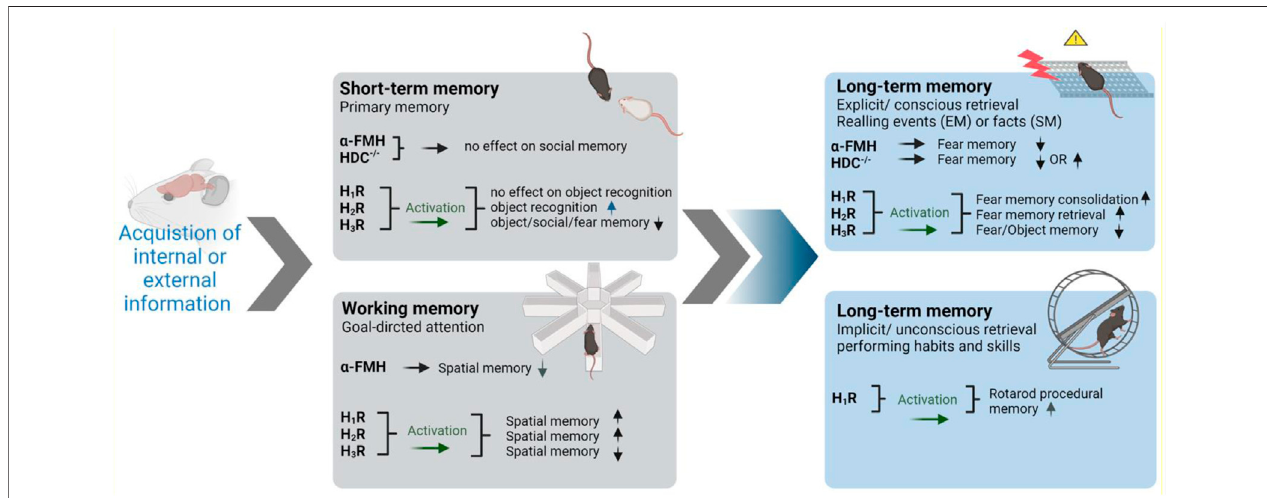
FIGURE 1 | Involvement of brain histamine in various types and stages of memory in preclinical studies. Symbolic photos were used to represent the most utilized behavioral task in each category. α -FMH, α - fl uoromethylhistamine; HDC-/-, histidine decarboxylase homozygous knockout mice; EM, episodic memory; SM, semantic memory. The arrows pointing up indicate improved memory. The arrows pointing down indicate decrease in memory performance. Graphics were constructed utilizing BioRender software program and were also licensed for